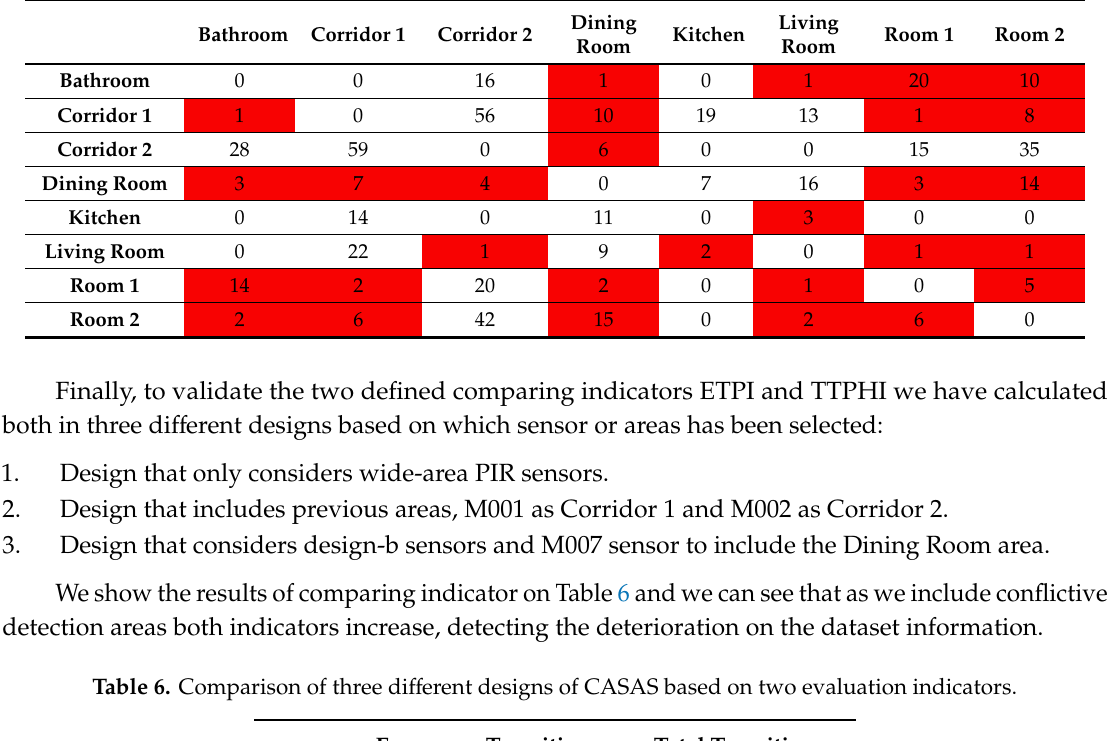
Table 5. Confusion matrix of transitions for CASAS using extra sensors.